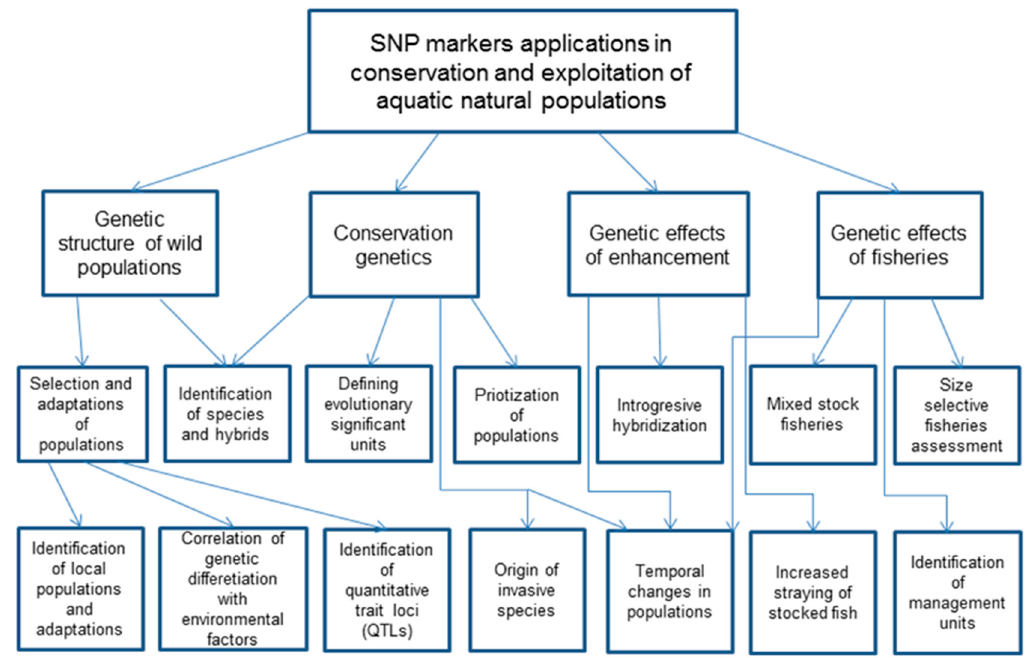
Figure 1. An integrated concept map showing the main fields and directions of SNP applications related to aquatic exploited animal populations. Table 1. List of species with sets of SNPs reported for the genetic structure studies of wild popula- tions.